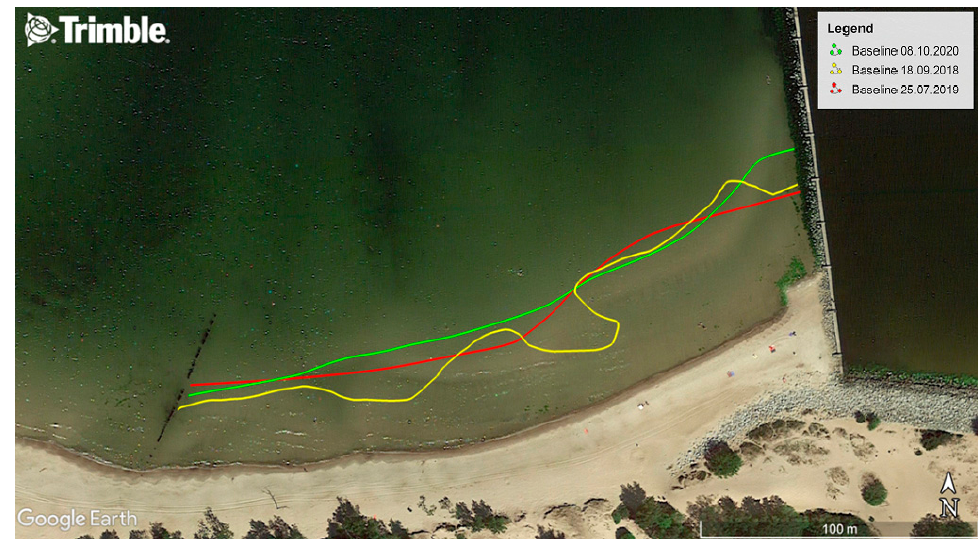
Figure 7. The course of the TSB of the waterbody located at the approach to Górki Zachodnie from the Gda´nsk Bay measured with the hydrographic method in 2018–2020.